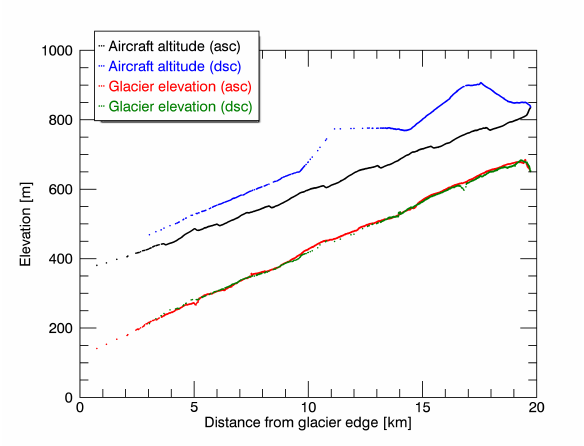
Figure 7: Elevation profile of the Kongsvegen glacier retrieved by laser altimeter. Both ascending (asc) and descending (dec) legs are shown. The aircraft flight altitude is shown for